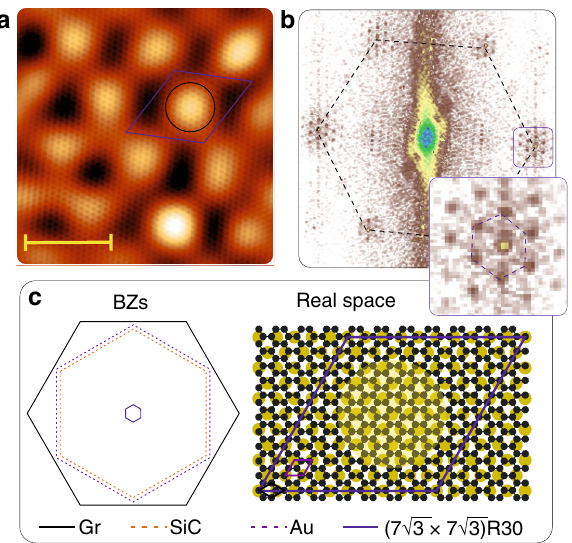
Fig. 4 Moiré structure of M 2D-Au. a STM image 2D-FFT fi ltered U sample = − 105 mV I = 325 pA. Scale-bar 3nm. b 2D-FFT of the real-space image tunnel in panel a . In the inset: zoom-in with respect to the blue box in panel b . c Reciprocal and real-space arrangement between graphene and gold. All BZs are 90° rotated in order to match the alignment used for the ARPES